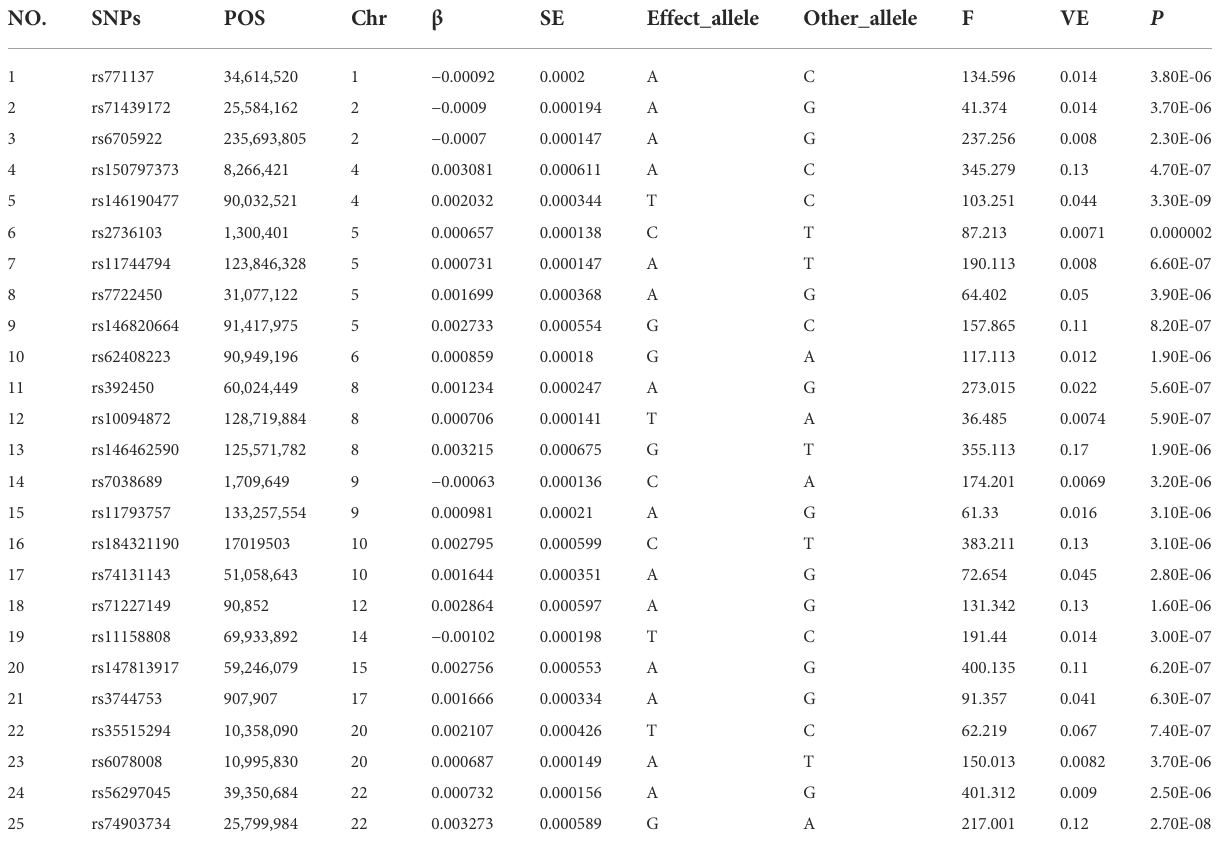
TABLE 5 MR effect size of BLCA on BPH with details of selected